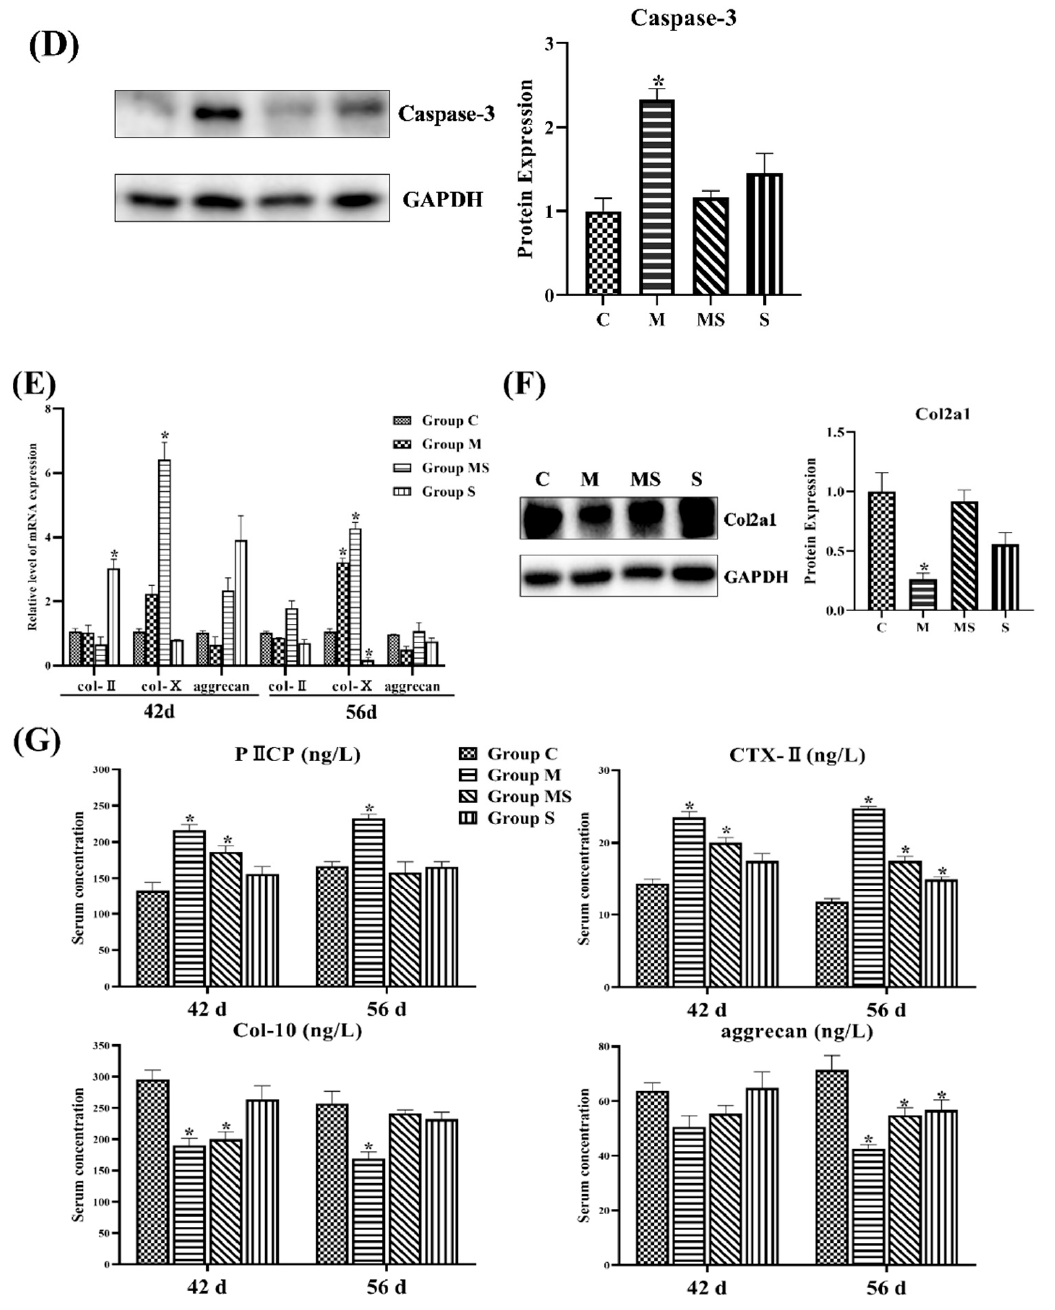
Figure 1. MP induced FHN in broilers. ( A ) The H&E staining of the femoral head in normal femoral head including articular cartilage ( AC ), proliferative zone ( P ), prehypertrophic zone ( PH ), and hypertrophic zone ( H ). ( B ) The H&E staining of articular cartilage in different group. The red arrow points to the chondrocytes with intracytoplasmic vacuoles and pyknosis. ( C ) The H&E staining of chondrocytes in the hypertrophic zone in different groups. ( D ) The caspase-3 expression of articular cartilage in different groups. ( E ) The 42 d and 56 d RNA expression of ECM. ( F ) The col-2a1 expression of articular cartilage in different groups. ( G ) The changes in serum collagen-II decomposition product (CTX-II), collagen-II synthesis product (PIICP), collagen-X, and aggrecan in different groups. * p < 0.05 vs. control group.